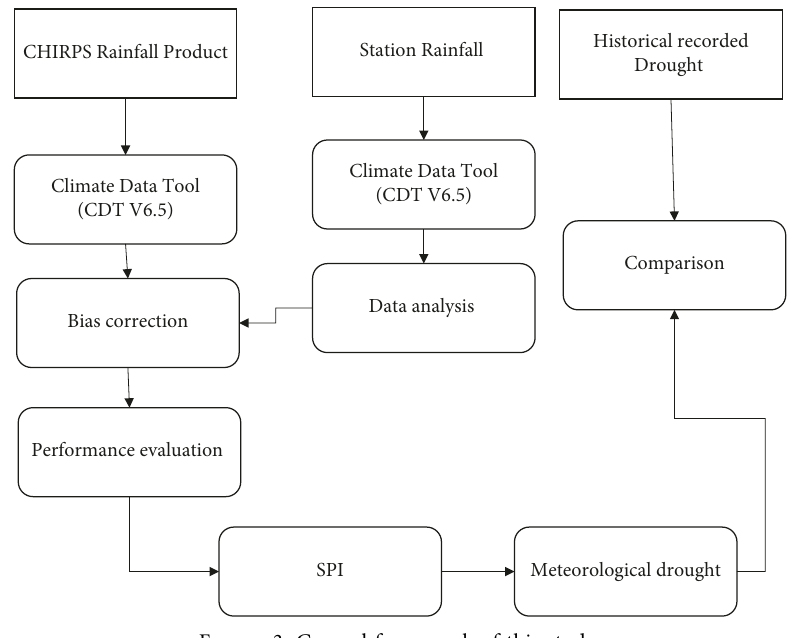
Figure 3: General framework of this study. Table 5: Performance statistics by comparing monthly CHIRPS rainfall with gauge data during 2000–2020 to evaluate the performance of CHIRPS monthly rainfall (spatial average).